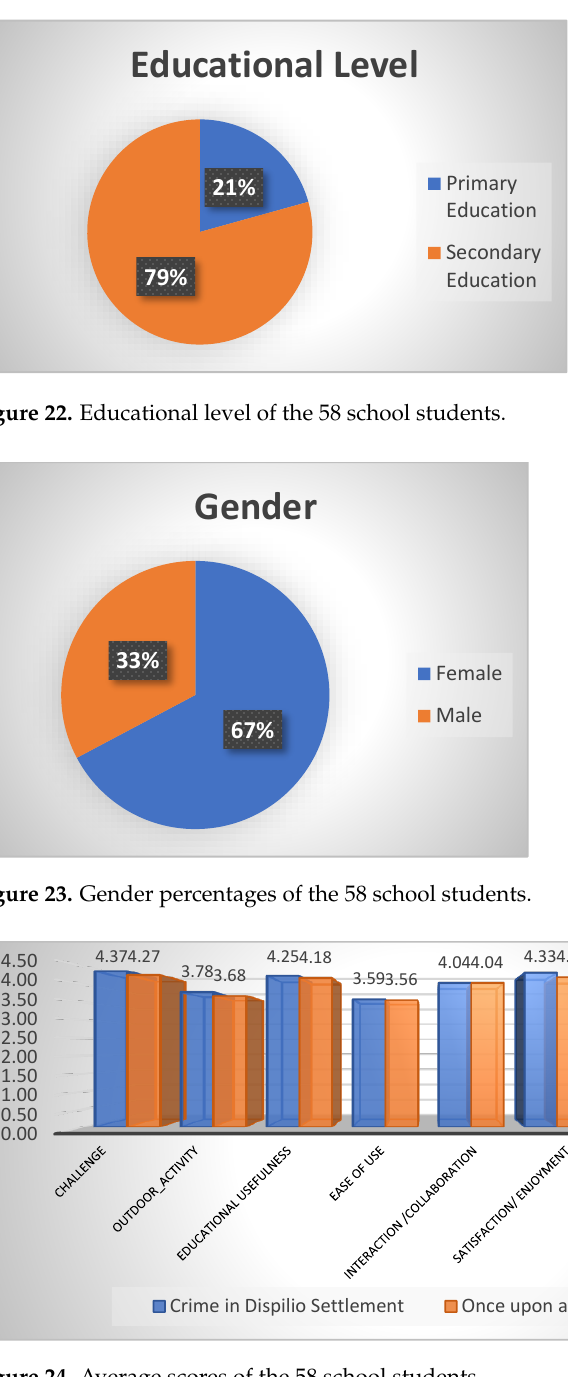
Figure 25. The storytelling game was again found to be more fun and engaging.